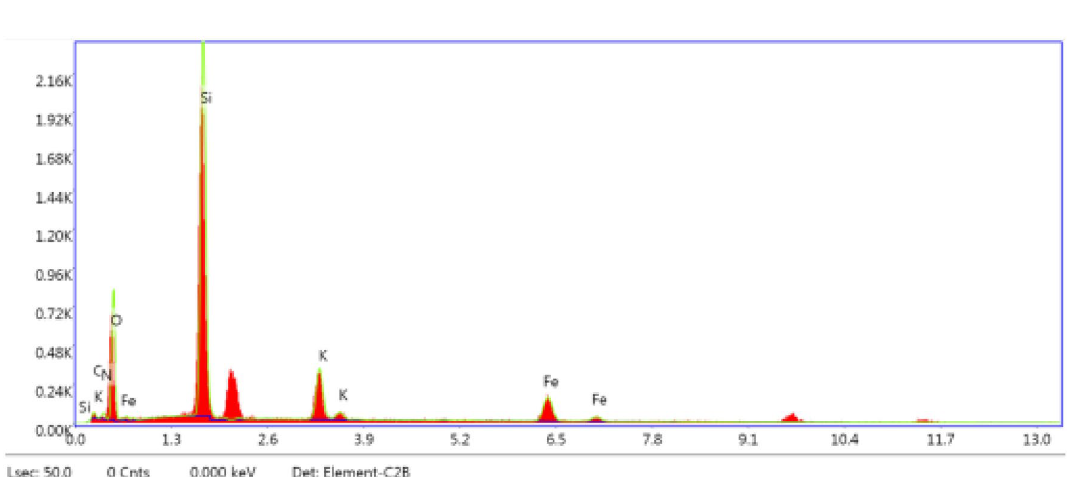
Figure 4. Energy dispersive X-ray spectroscopy of superhydrophobic nanosilica